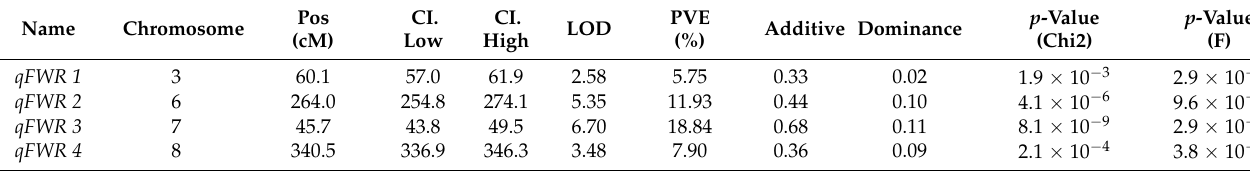
Table 2. QTL peak loci (LOD > 2.5) from Composite Interval Mapping (CIM), with three different phenotyping trial data. Position on genetic map and confidence interval (CI. low, CI. high) is indicated for each QTL peaks, as well as LOD, Percentage of Variance Explained (PVE), p value by Chi-square test and